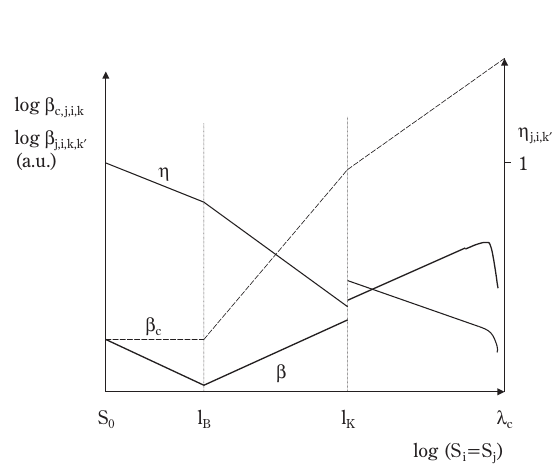
Fig. 3 Collision and overall agglomeration rate constant against the common size of mother particles for collision of parti- cles of the same size. Case of very low growth